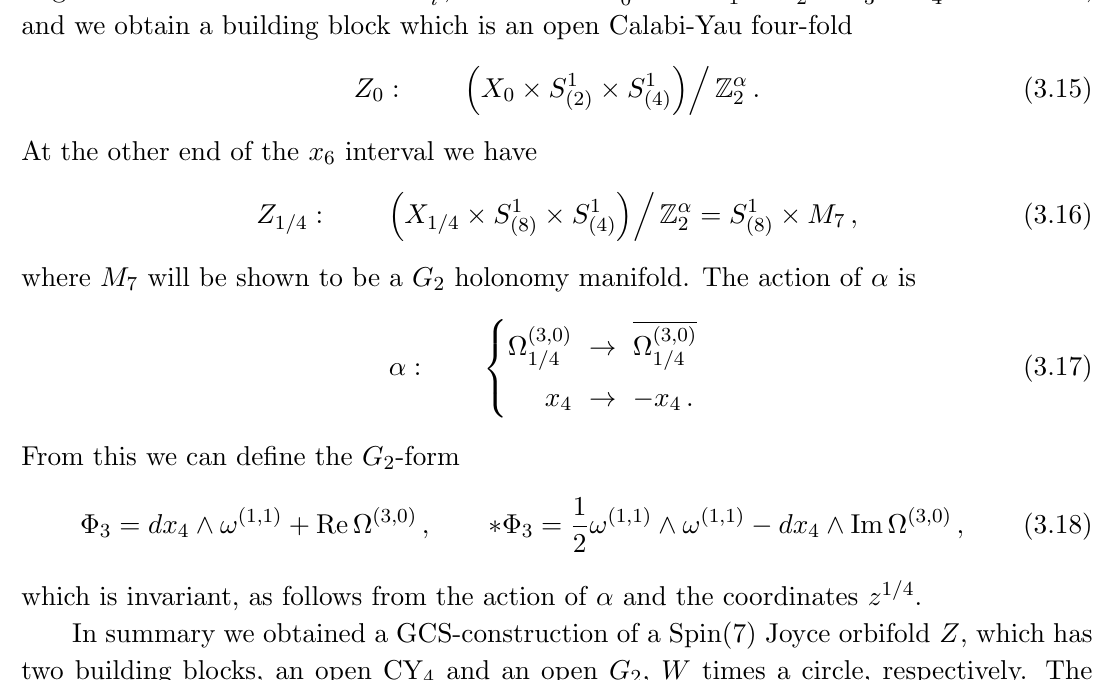
JHEP06(2018)103 . These are glued (8)